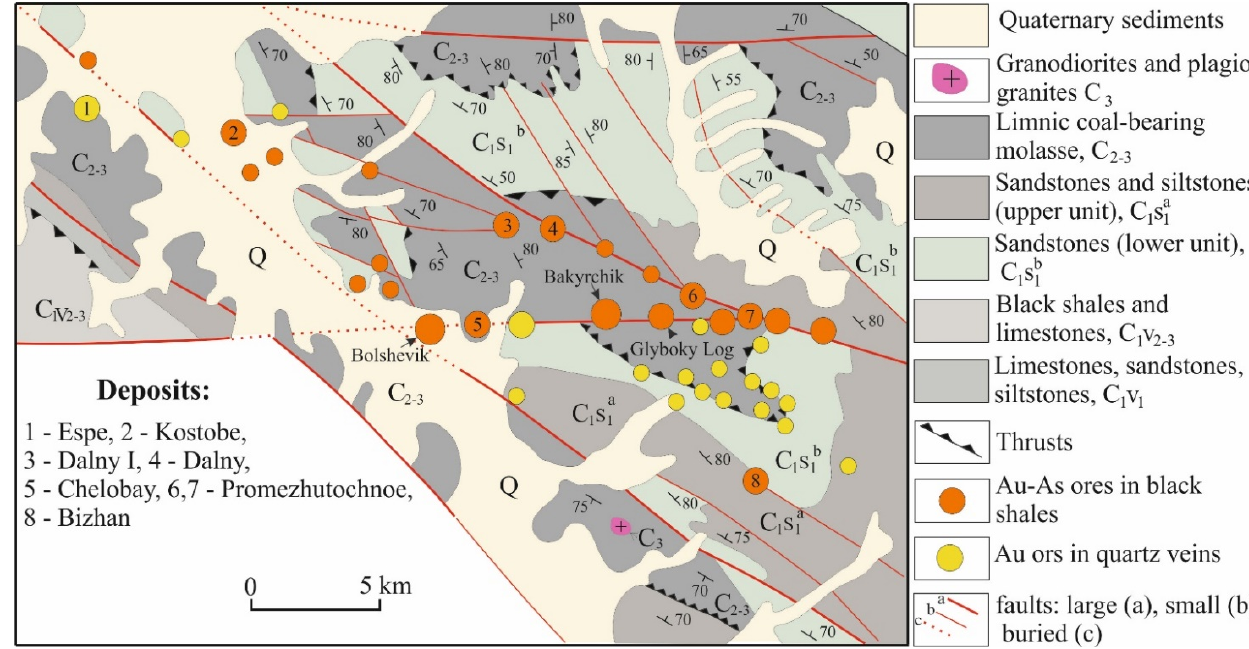
Figure 10. Location map of deposits in the Bakyrchik ore field (using unpublished data of V.I. Tikhonenko).